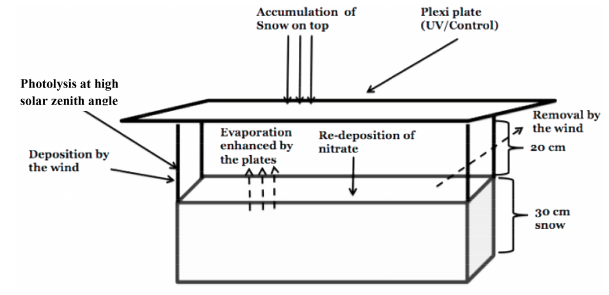
Figure 9. Schematic showing the possible external processes that could affect the surface layers of both the UV and control pits. These include evaporation, wind deposition and/or removal and photolysis at high solar zenith